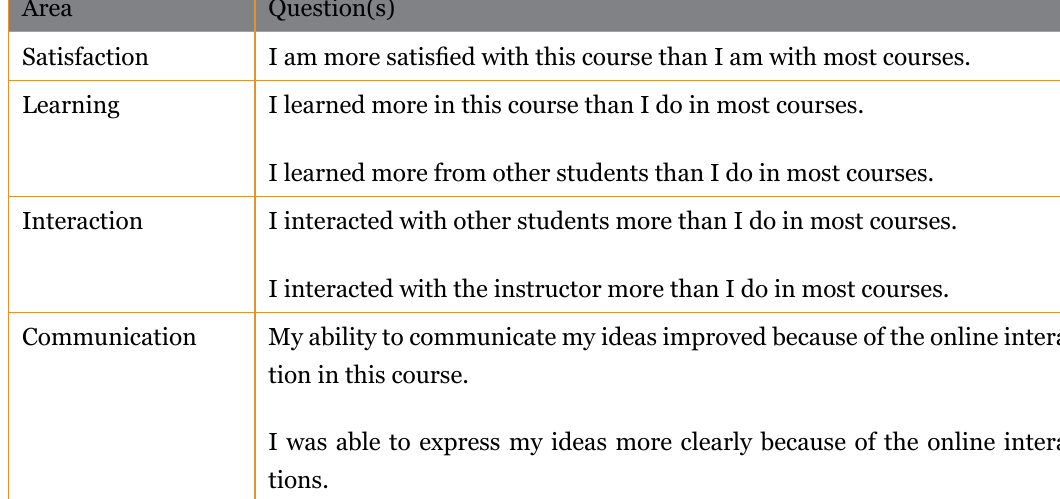
Figure 2 . Grade distributions of F2F and online sections of College of Liberal Arts courses.